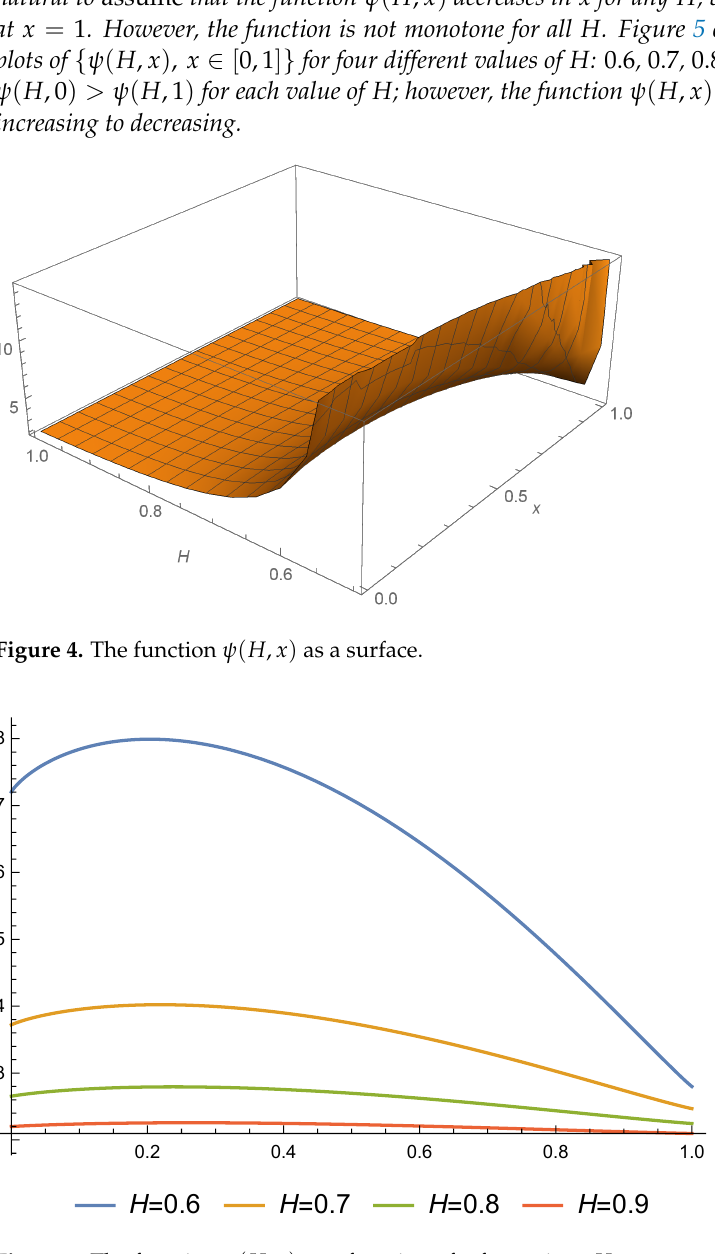
Figure 5. The function ψ ( H , x ) as a function of x for various H